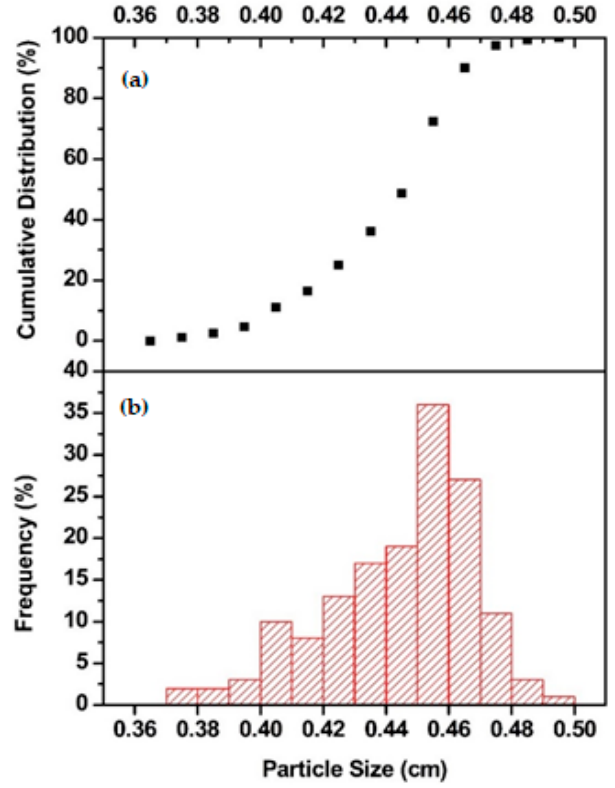
Figure 1. Particle size distribution of alginate aerogel particles in 500 mL batch volume before the experiments. ( a ) The cumulative particle size distribution. ( b ) The particle size distribution.